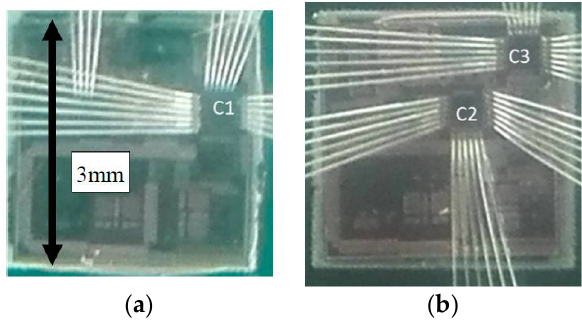
Figure 10. The chip-bonding photos of ( a ) test group 1; ( b ) test group 2; and test group 3.